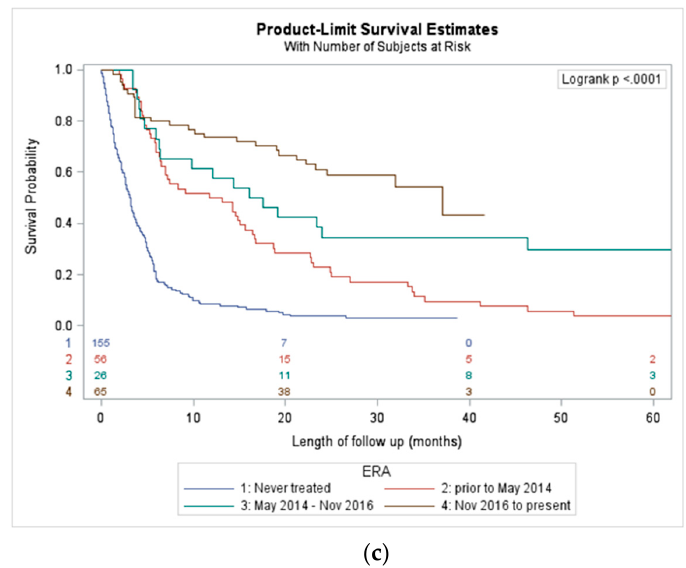
Figure 1. ( a ) Overall survival outcomes by era of novel therapy; ( b ) overall survival outcomes by era in BRAF mutant- melanoma; ( c ) overall survival outcomes by era in unknown or wild-type BRAF mutation status.